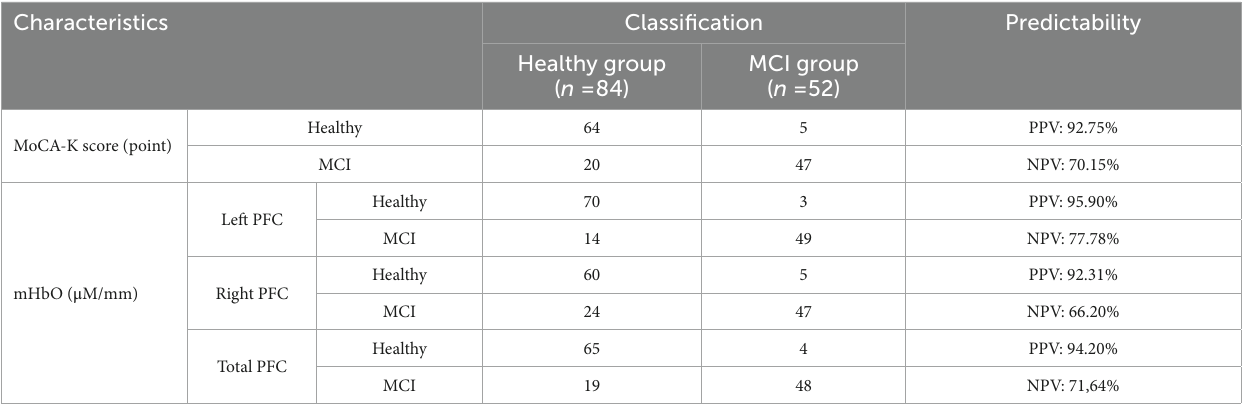
TABLE 4 Predictability of the mHbO value and the MoCA-K to distinguish between healthy controls and people with MCI ( N = 136).